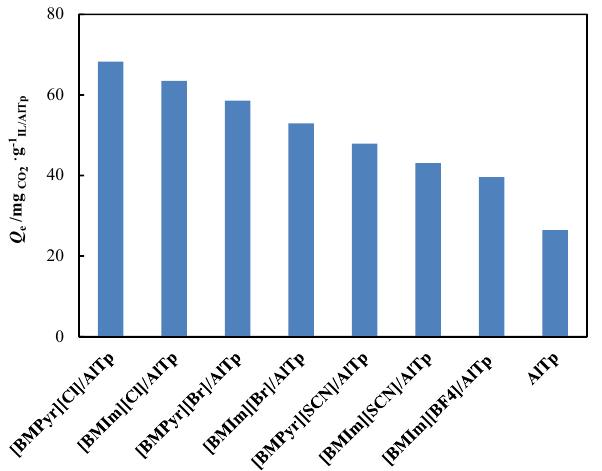
Figure 8. Graphical comparison of CO 2 adsorption capacity in the different IL/AlTp systems at temperature 298.15 K and pressure 5 bar.